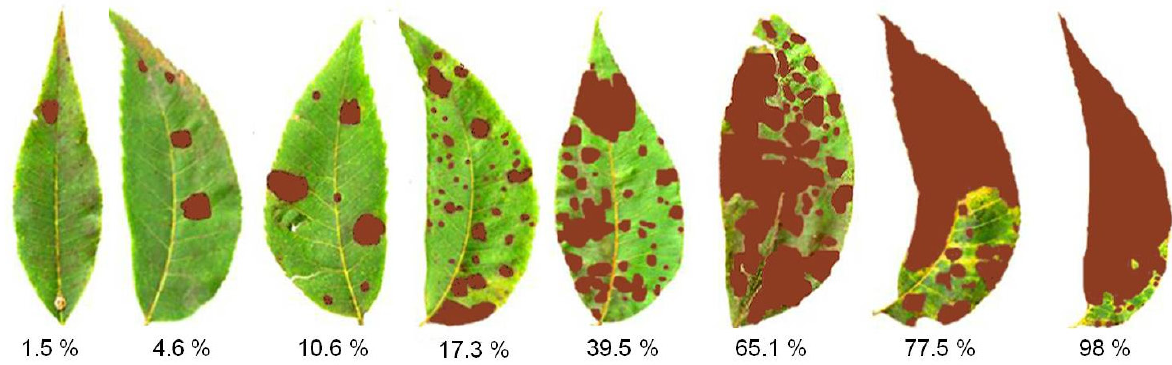
Figure 1. Proposed diagrammatic scale to evaluate the severity of brown leaf spot on leaflets of Carya illinoinensis . Percentage values of symptomatic leaf area. Table I. Linear ( a ), angular ( b ), and determination coefficients ( R 2 ) and absolute error (AE) in modulus obtained in regressions between true and estimated disease severity on leaflets of Carya illinoinensis showing brown leaf spot symptoms, with and without the use of the diagrammatic scale.